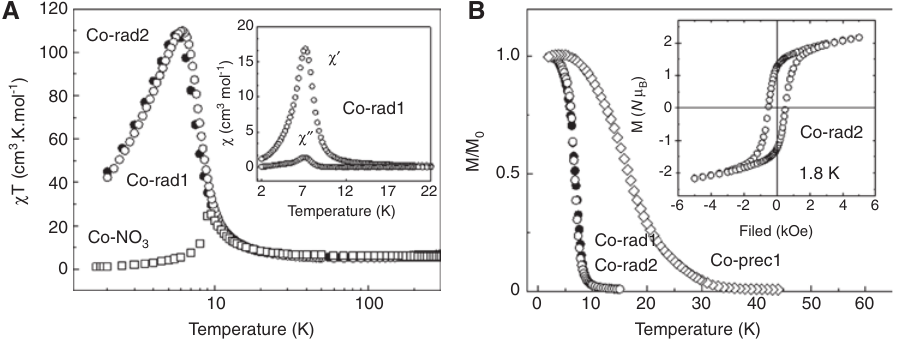
Figure 8: Substitution with benzoate radical anion (A) comparison of the magnetic susceptibility of the starting cobalt hydroxynitrate (metamagnetic) and exchanged products Co-rad1 and Co-rad2 (ferromagnetic) with the variation of the alternative susceptibility of Co-rad1 in insert; (B) T changes related to the presence or absence of the radical. Adapted with permission from [91]. Copyright 1998 C